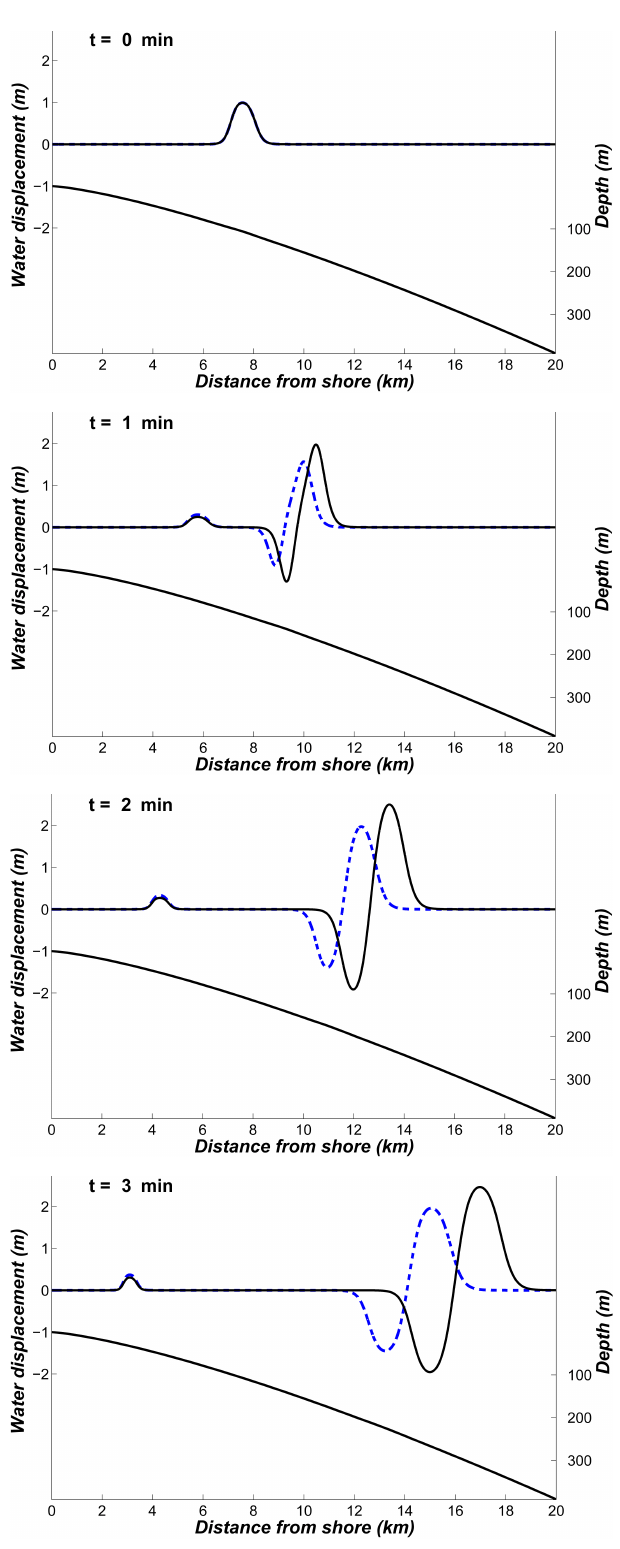
Fig. 5. Wave dynamics along the bottom profile h ∼ x 4 / 3 in subcritical (blue dashed line) and supercritical (black line) regimes.